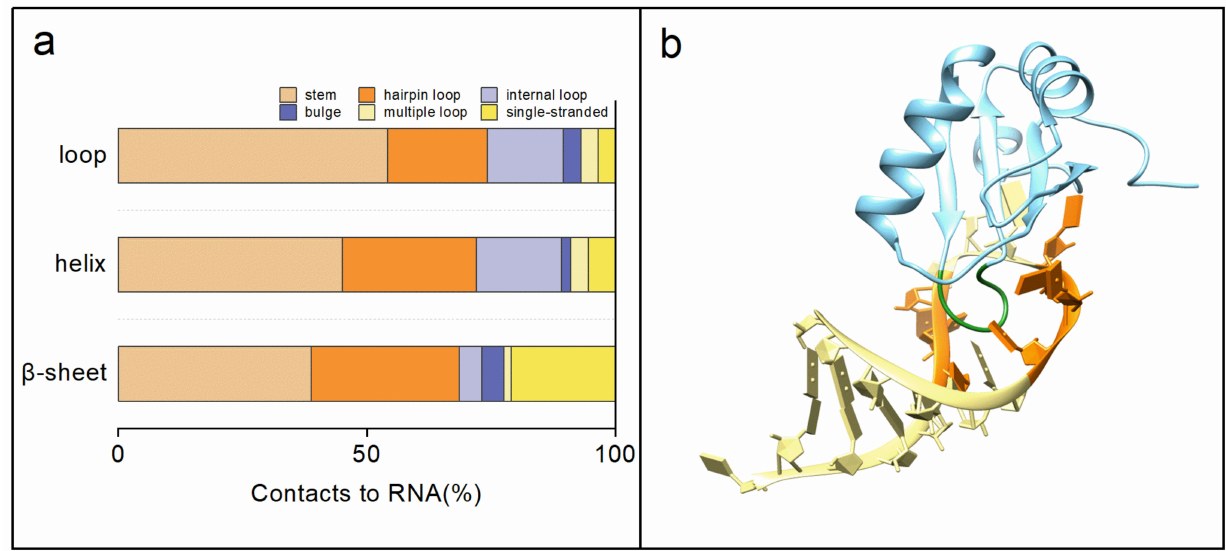
Figure 3. ( a ) The secondary structure distributions at the RNA–protein interaction interface. The protein loops prefer to bind to the RNA stem region. ( b ) An example of a protein loop binding to an RNA stem region (PDB code: 1URN). Green and orange represent the binding interface between protein and RNA.